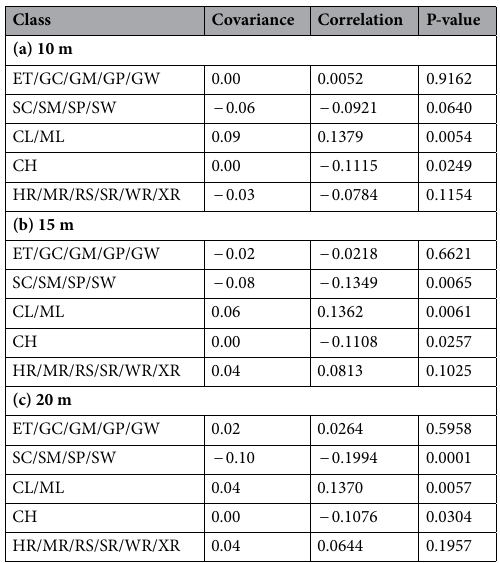
Table 6. Geotechnical data correlation analysis: depths of (a) 10 m, (b) 15 m, (c) 20 m.